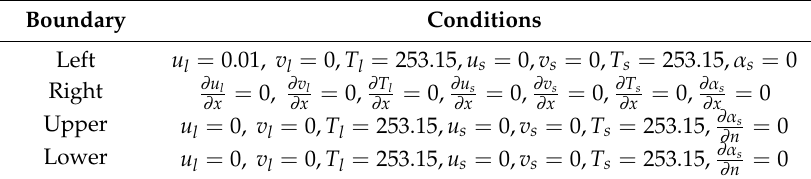
Table 4. The settings of the boundary conditions (Case 3, 4, 5, 6).